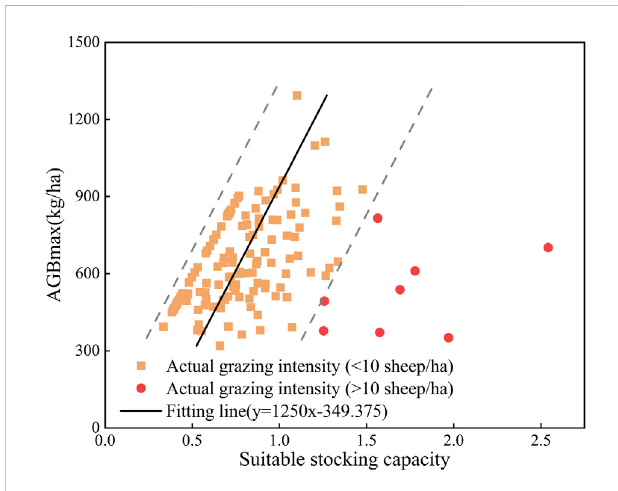
FIGURE 10 The relationship between AGBmax and the change of suitable grazing